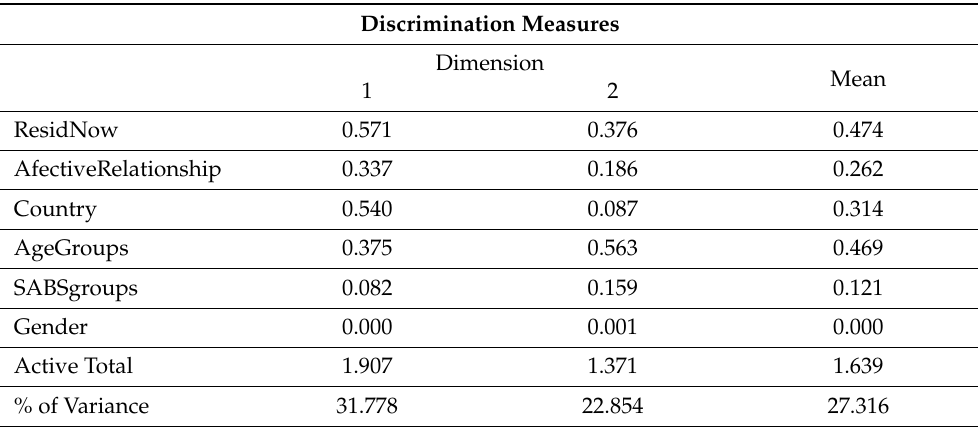
Table 3. Discrimination measures of variables entered in the 2-dimensional